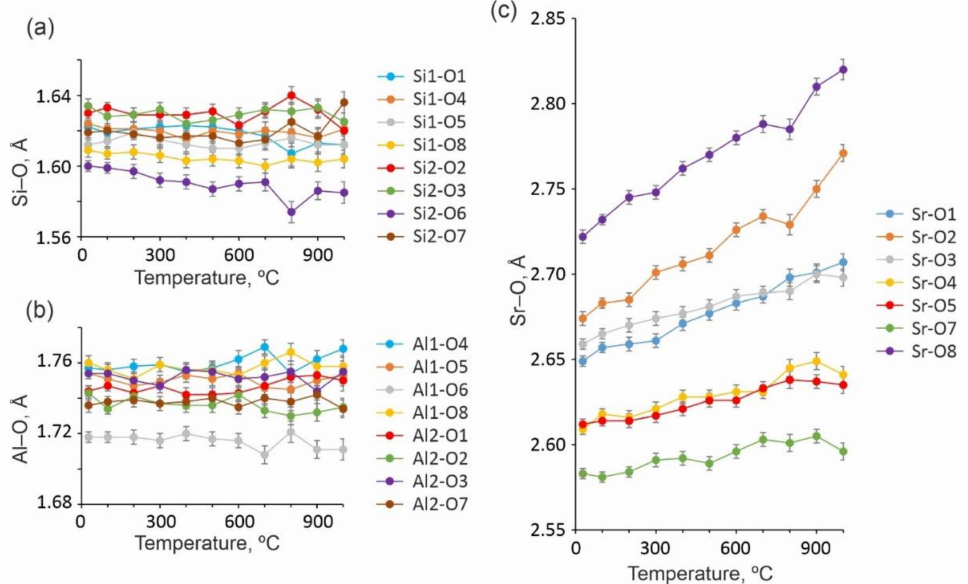
Figure 6. Temperature dependence of Si–O ( a ), Al–O ( b ), and Sr–O ( c ) interatomic distances in the crystal structure of